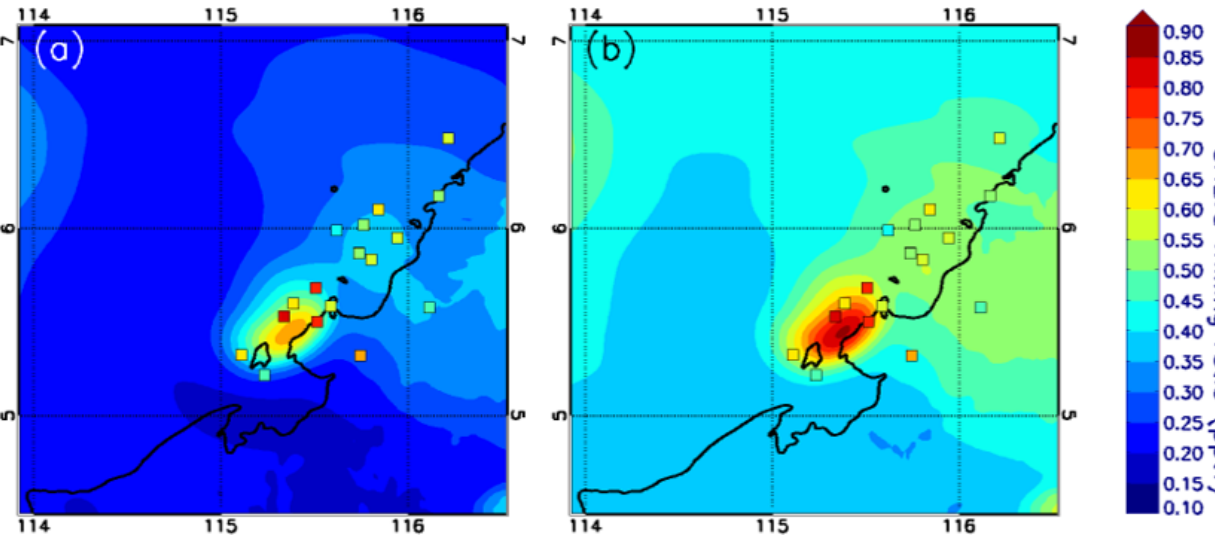
Figure 7. Map of the modelled CHBr 3 mixing ratios in parts per trillion by volume for Mod_Conv_5.4N at 10:00UTC and 12.5km altitude (a) . The squares represent the CHBr 3 mixing ratios measured by the GHOST instrument within and in the vicinity of Obs_Conv1. 10:00UTC corresponds to the time when Mod_Conv_5.4N is at the convective mature stage, i.e. the anvil is well developed. Because of the difference in location between Obs_Conv1 and Mod_Conv_5.4N, the observations are shifted in space to fit with the centre of Mod_Conv_5.4N anvil. Panel (b) is similar to (a) but with 0.17pptv added to the modelled CHBr 3 to account for the underestimation of Mod_Conv_5.4N in the UT (conv and noconv) from Table